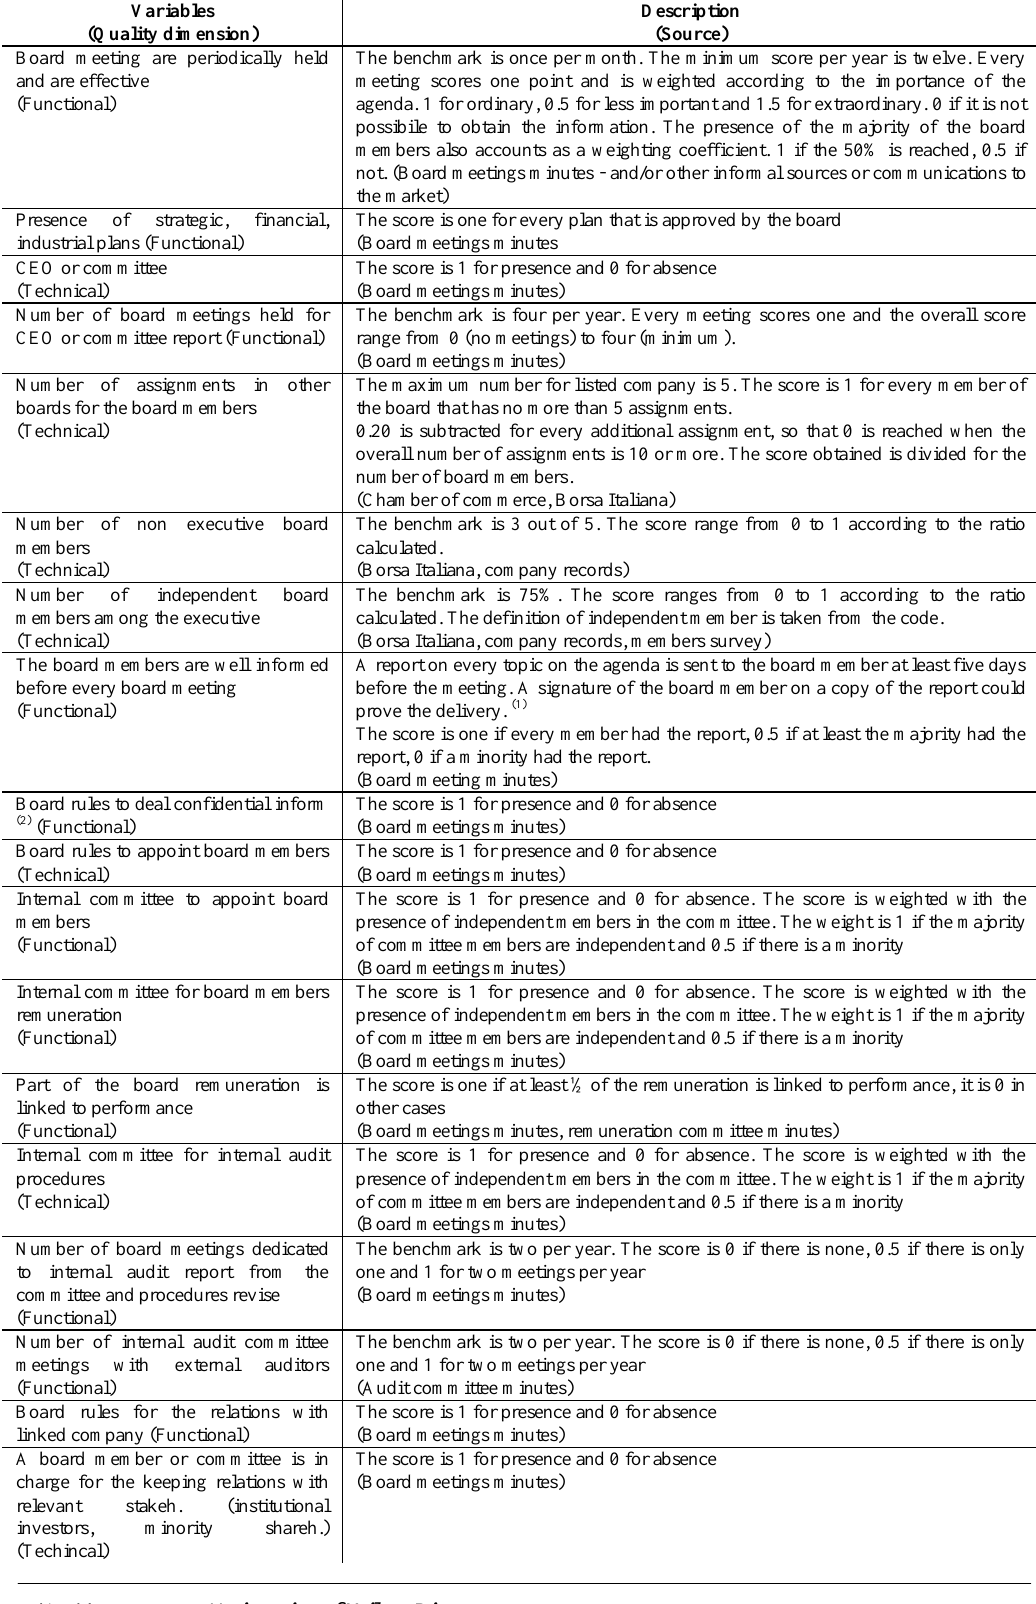
Table 3.1: The Variables for Corporate Governance Code Rating System Variables (Quality dimension)